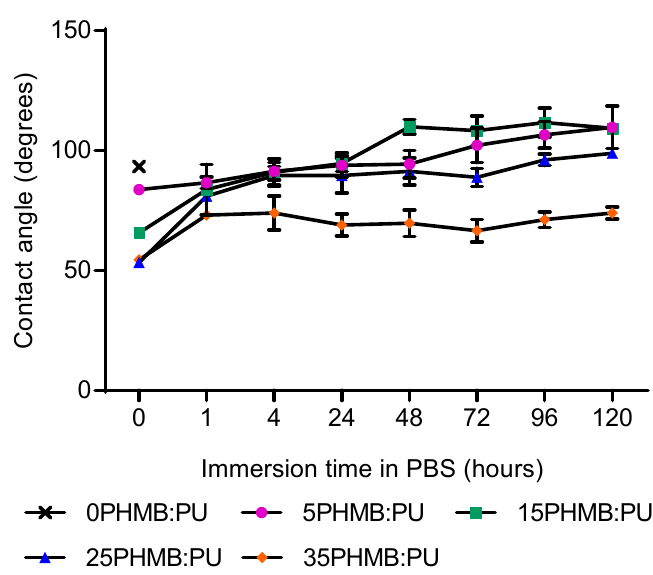
Figure 7. The contact angle change of electrospun PHMB:PU membranes after immersion in PBS. Changes in contact angle inversely indicate changes in wettability as PHMB was released. Error bars describe the standard deviation from the mean, with n = 3. 0 h measurements for 35PHMB:PU membranes were taken but were found to give unstable droplet formation, indicating higher hydrophilicity than reported.